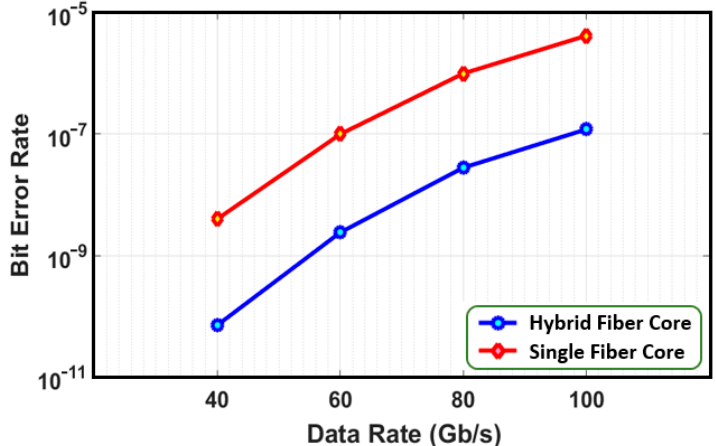
Figure 11. Performance summary for various data rates of an RZ-DQPSK modulated signal, comparing the three-segment hybrid fiber core structure and the conventional single fiber core structure after a 390-km transmission.